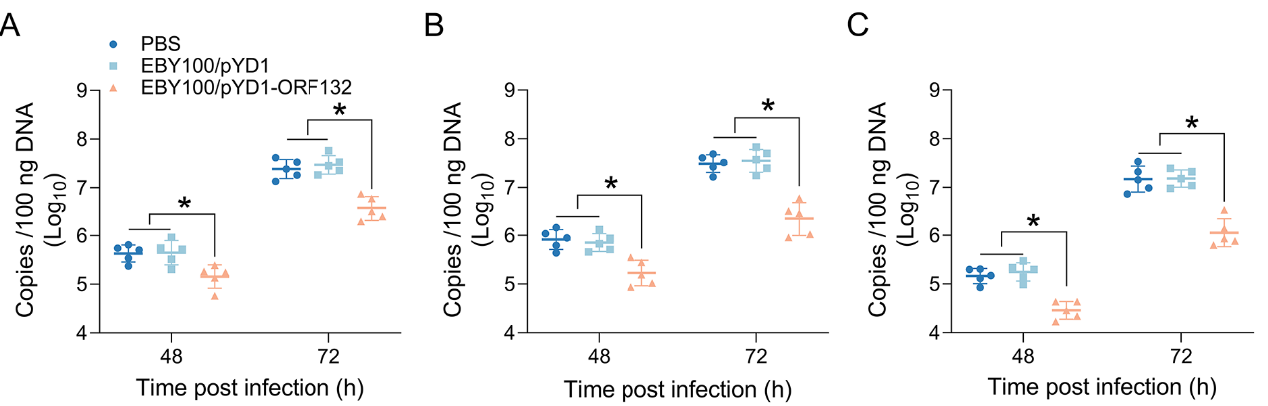
Figure 6. The virus load in head–kidney ( A ), spleen ( B ), and hindgut ( C ) at 48 and 72 h post CyHV-2 infection. The data were conducted using one-way analysis of variance with Bonferroni correction, and expressed as the mean ± SEM, n = 5, * p <